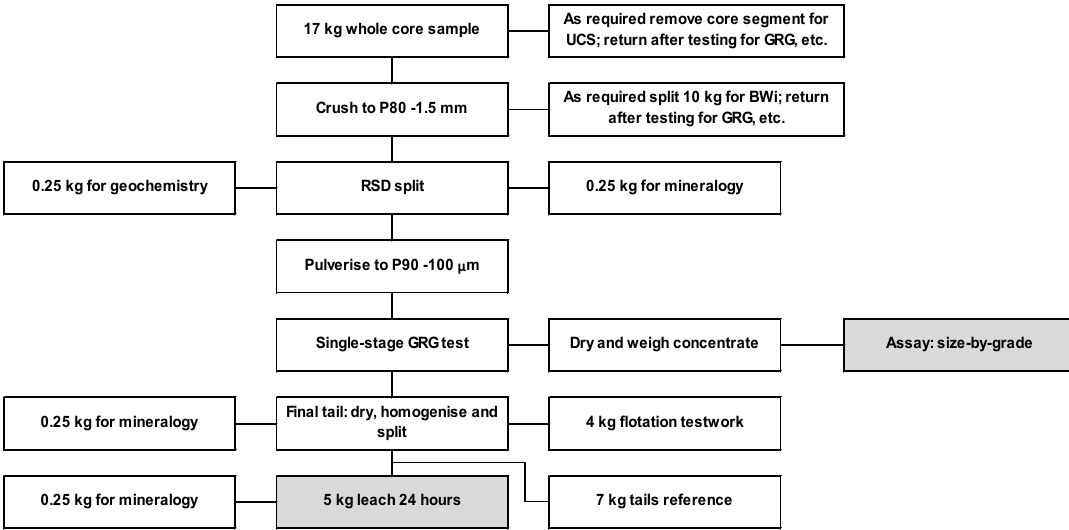
Figure 5. Geometallurgical testwork flow-sheet for drill core and underground samples. The GRG test concentrate grade and tails leach grade (grey shaded boxes) are recombined to provide a head grade for the sample. UCS: uniaxial compressive strength; BWi: Bond ball mill work index; RSD: rotary sample divider.